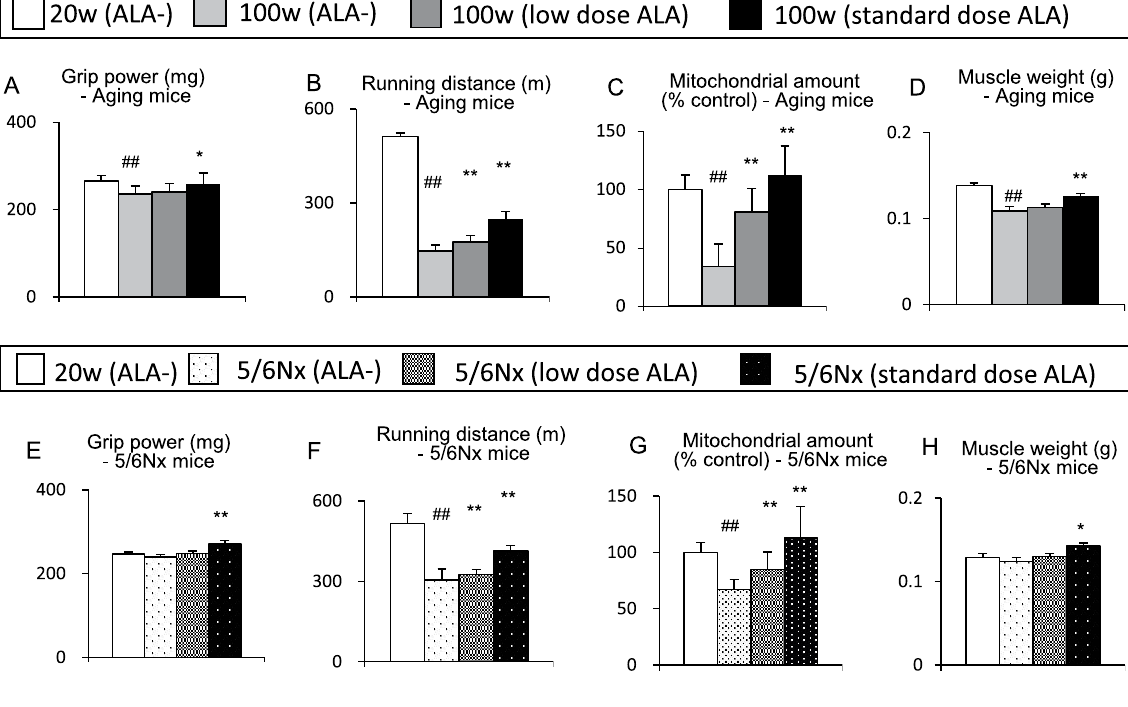
( B ) Running distance, ( C ) Mitochondrial amount and ( D ) Muscle weight of the gastrocnemius muscle), ( E–H ) 5/6Nx mice ( E ) Grip power, ( F ) Running distance, ( G ) Mitochondrial amount, ( H ) Muscle weight of the gastrocnemius muscle). N = 8 in each group. * P < 0.05, ** P < 0.01 versus aged mice without ALA-treatment or 5/6 Nx mice without ALA treatment group. # P < 0.05, ## P < 0.01 versus the control group. ALA, 5-aminolevlinic acid; 5/6Nx, 5/6